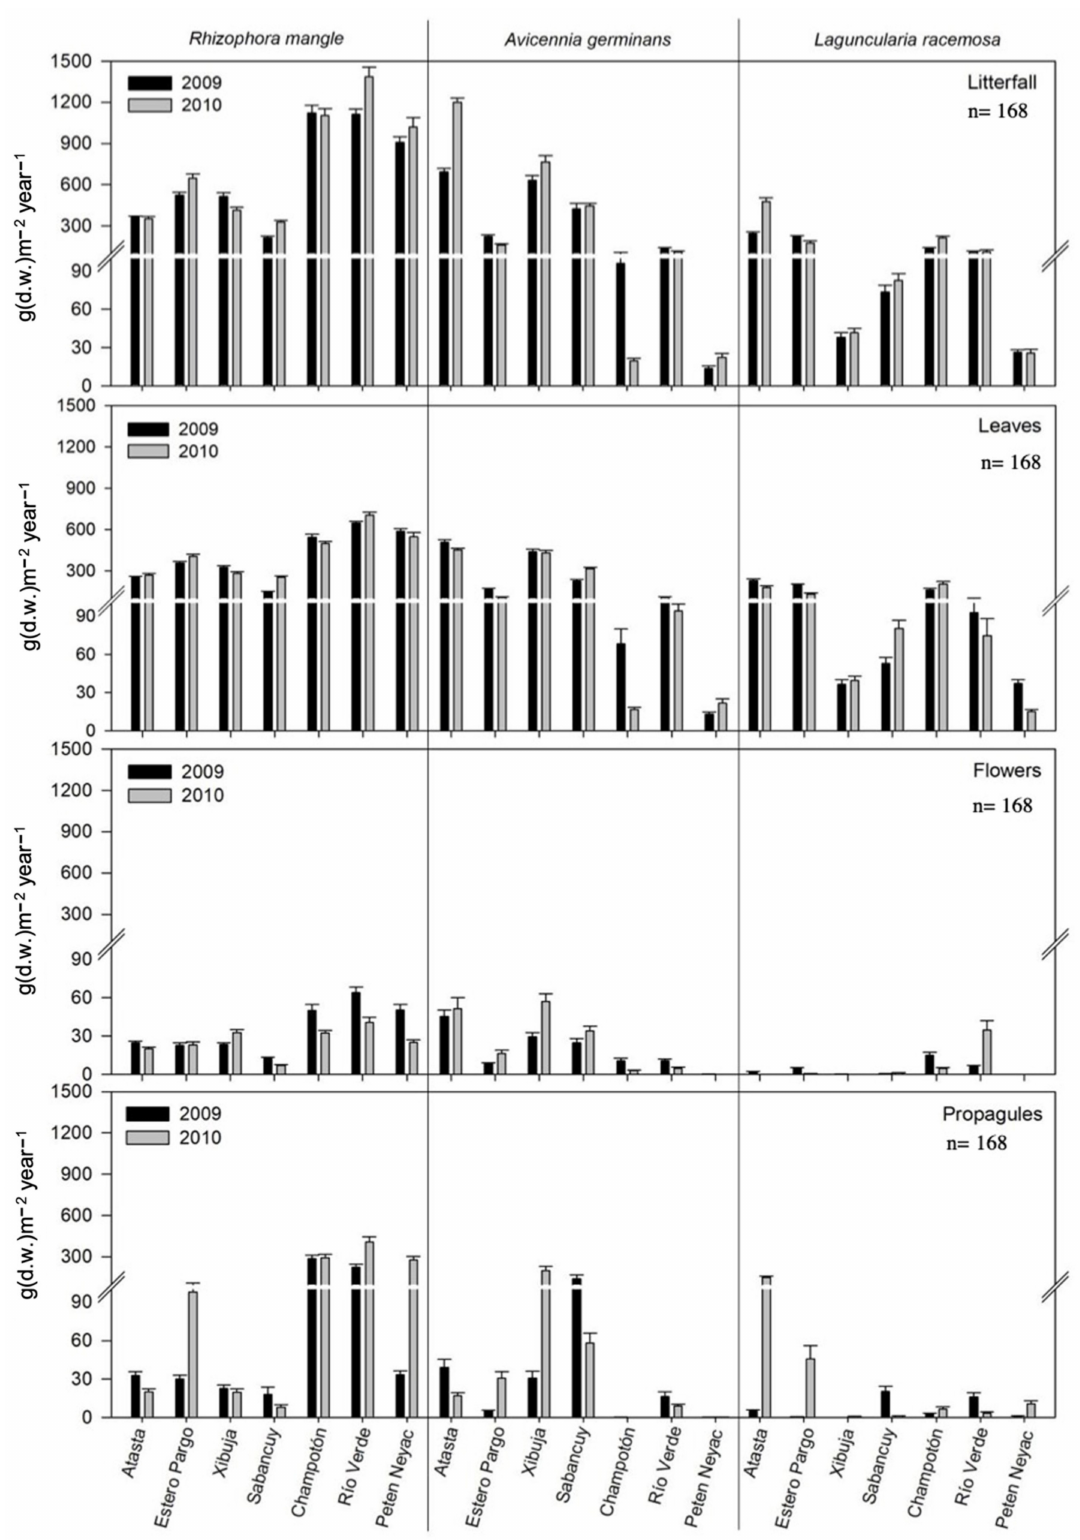
Figure 7. Litterfall and its components for each species ( ± SE = standard error), in the seven mangrove forests studied along the coast of Campeche for 2009 and